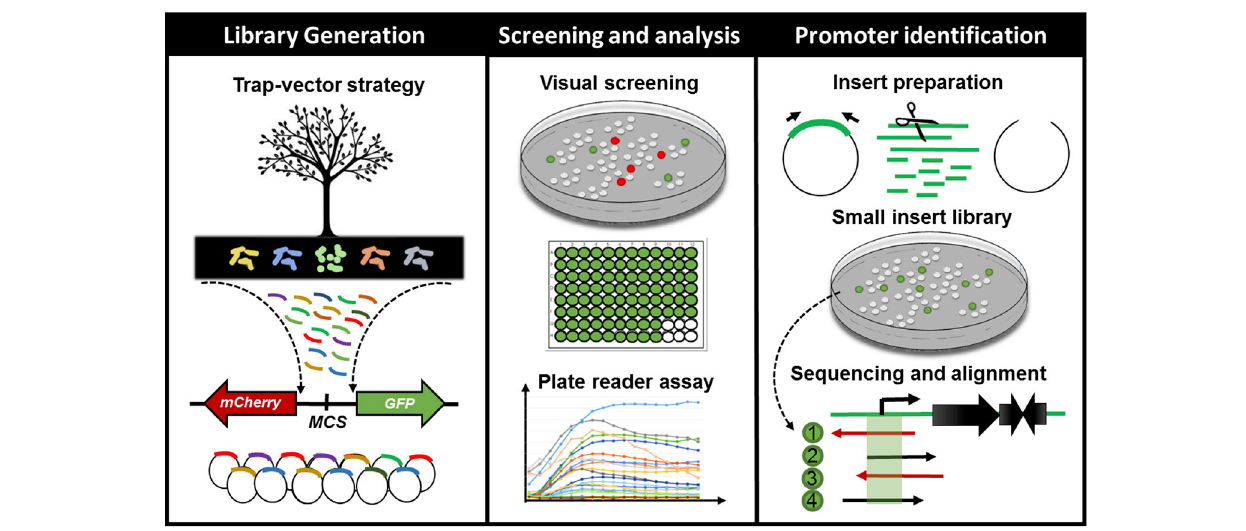
FIGURE 1 | Schematic representation of the workflow for finding, characterizing and cross-validating novel bacterial cis-regulatory elements in environmental samples. From left to right: firstly, we have generated metagenomic libraries from soil samples in E. coli DH10B. The DNA fragments were cloned into a bi-directional reporter trap-vector (bearing mCherry and GFPlva fluorescent reporters), pMR1, which allowed for the screening of promoters in both DNA strands. Secondly, we have manually screened all visible fluorescent clones from our metagenomic libraries and analyzed the expression patterns of all green fluorescent clones on a microplate reader during 8h. Lastly, we have selected 10 clones based on their GFPlva expression patterns for an in-depth analysis combining experimental (small DNA insert library generation) and in silico promoter prediction. This integrated strategy has allowed us to identify, validate and estimate the accessibility of novel promoter regions from metagenomic libraries.